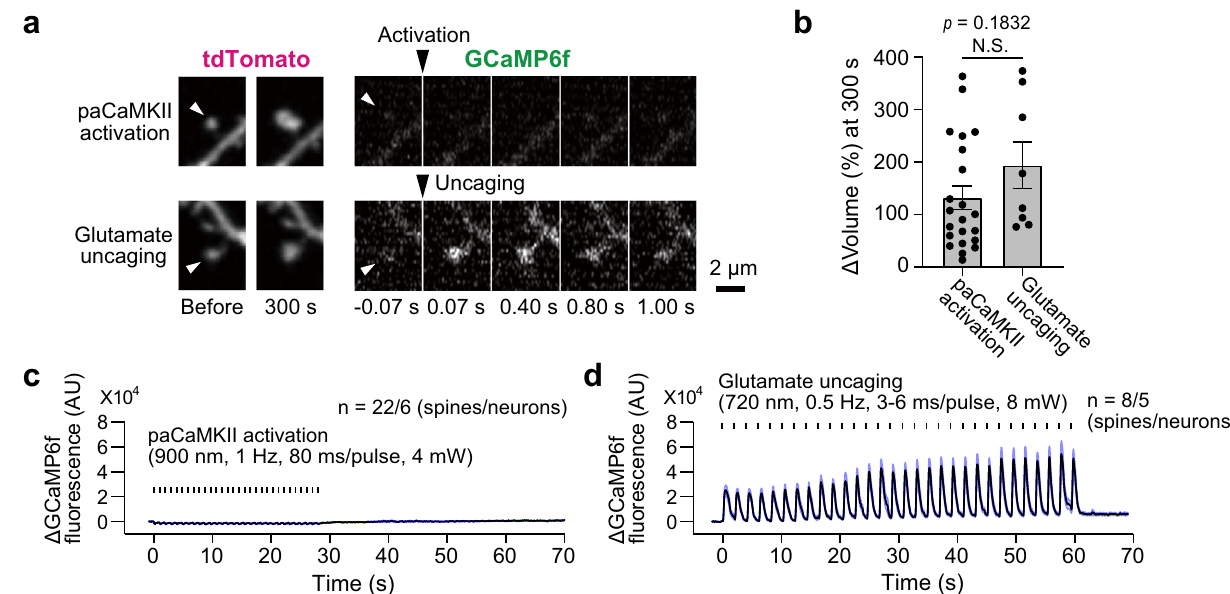
Fig. 4 Calcium imaging during glutamate uncaging and paCaMKII activation. a Images of dendritic spines of a neuron expressing Ca 2 + indicator GCaMP6f and tdTomato-P2A-paCaMKII. Both GCaMP6f and tdTomato were simultaneously imaged by two-photon excitation at 1000 nm. paCaMKII activation at 900 nm (top) or glutamate uncaging at 720 nm (bottom) was used to stimulate the spine, respectively. Images were slightly noisy because they were acquired at a high temporal resolution (15.6 Hz). GCaMP6f and tdTomato images were averaged over 3 and 30 frames, respectively. Arrowheads indicate the stimulated spines. b Quanti fi cation of spine volume change at 300 s. n (spines/neurons) = 22/6-paCaMKII activation, 8/5 glutamate uncaging. The data are presented as mean ± SEM; N.S. not signi fi cant, represents p > 0.05; two-tailed unpaired t test. Ca 2 + transients in the stimulated spine by paCaMKII uncaging ( c ) or glutamate uncaging ( d ). The traces were averaged by three frames moving average. The number of samples is the same in b , and also indicated in the fi gures. Source data are provided as a Source Data fi